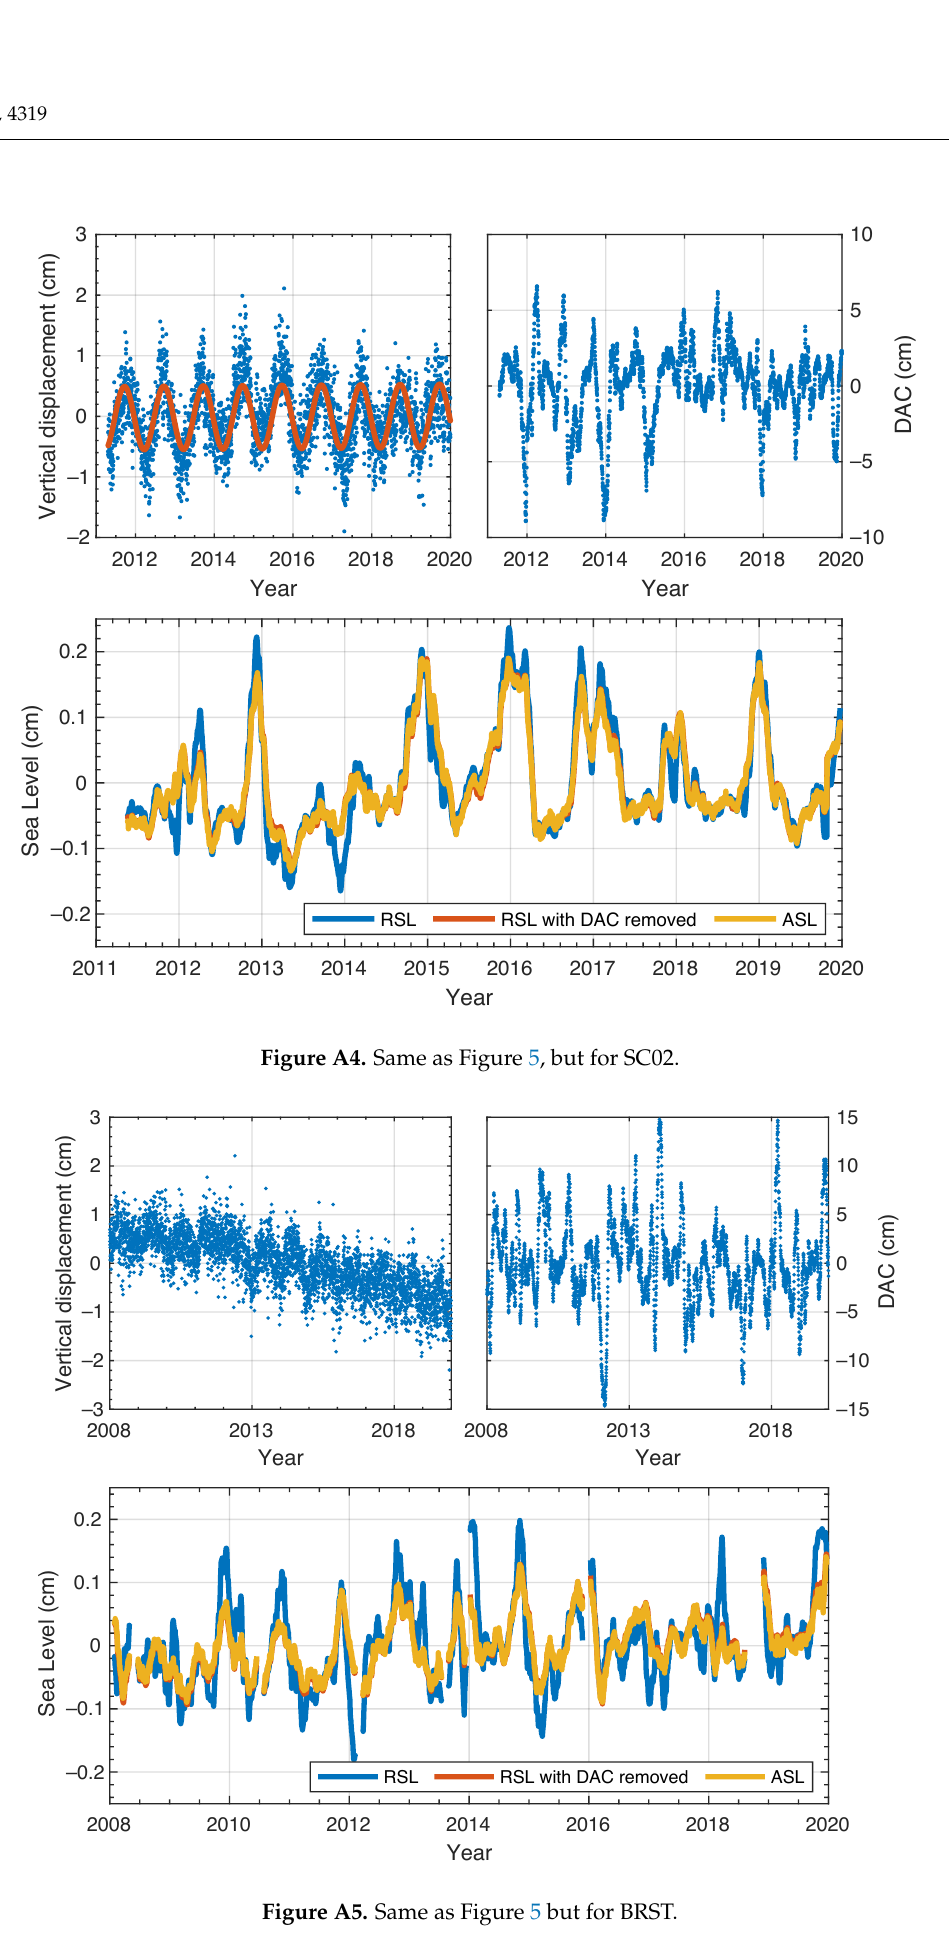
Figure A5. Same as Figure 5 but for